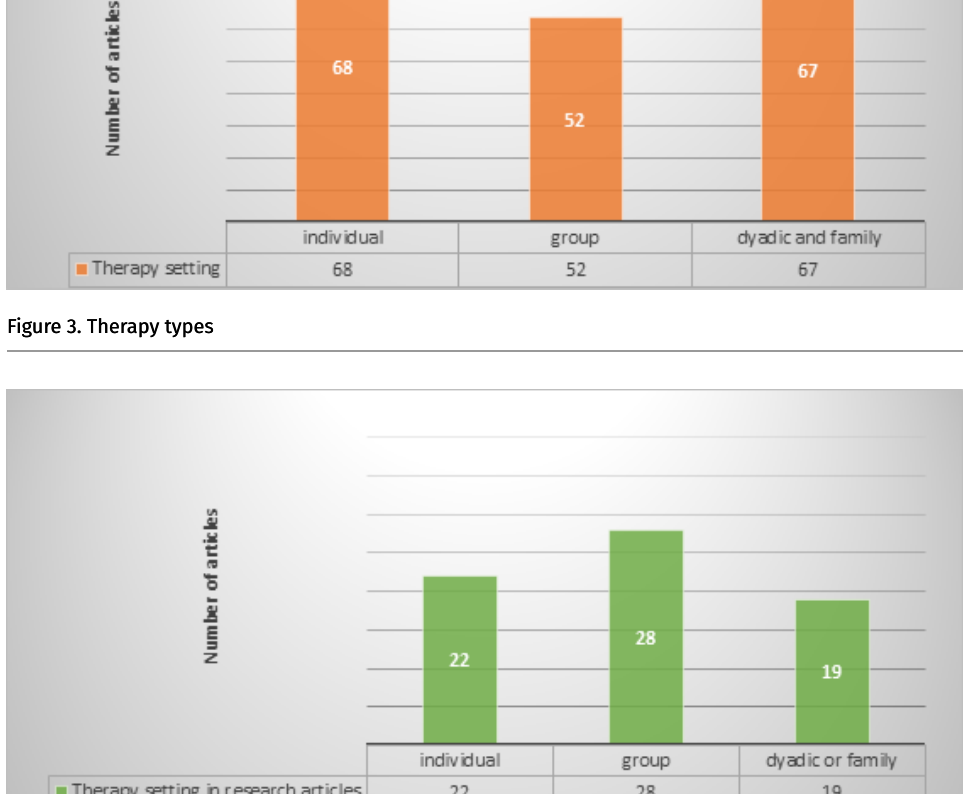
FFigigururee 4.4. TherTherapapyy ttypesypes inin rreseeseararchch